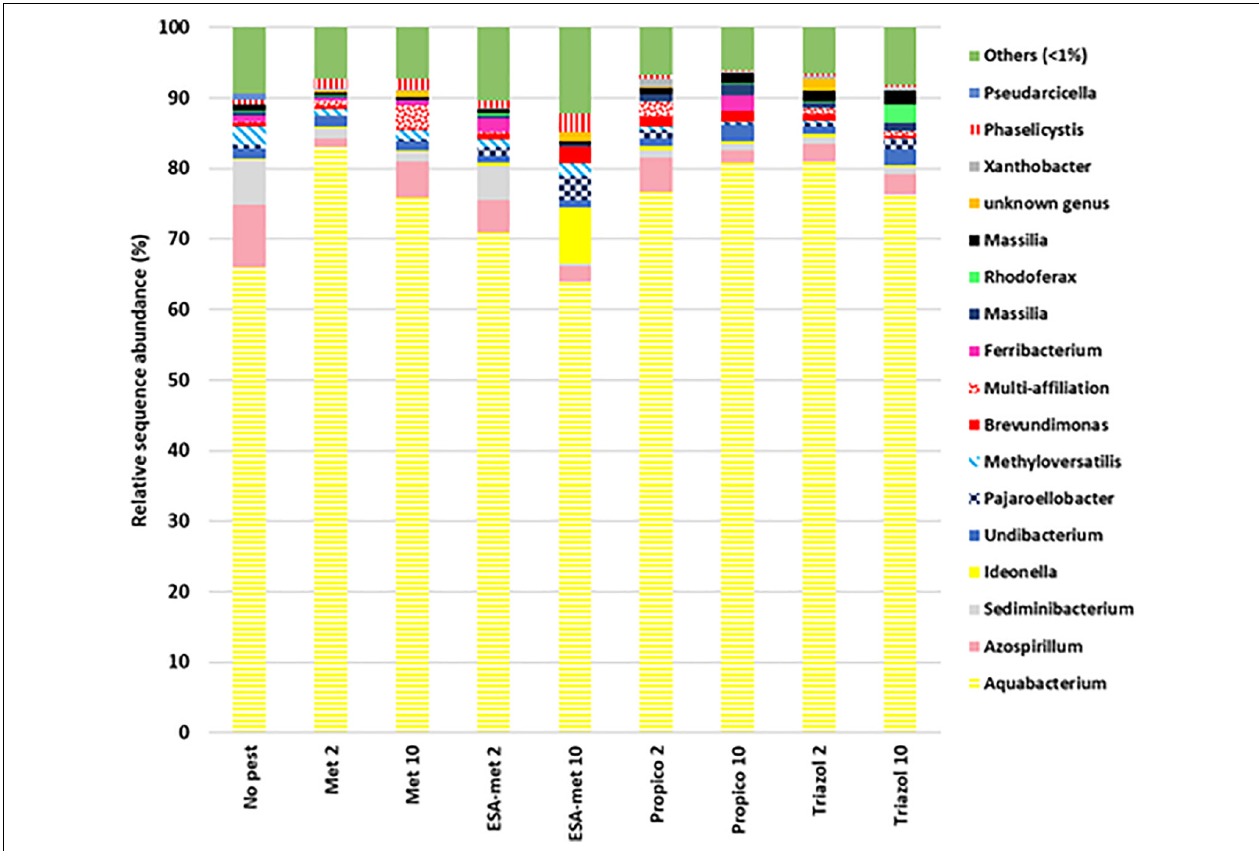
FIGURE 7 | Relative abundance of bacterial genera at the end of batch experiments, representing at least 1% of obtained sequences in at least one sample. Data represent average values of experimental replicates. No pest: control (absence of pesticides or metabolites); Met: metolachlor; ESA-met: ESA-metolachlor;